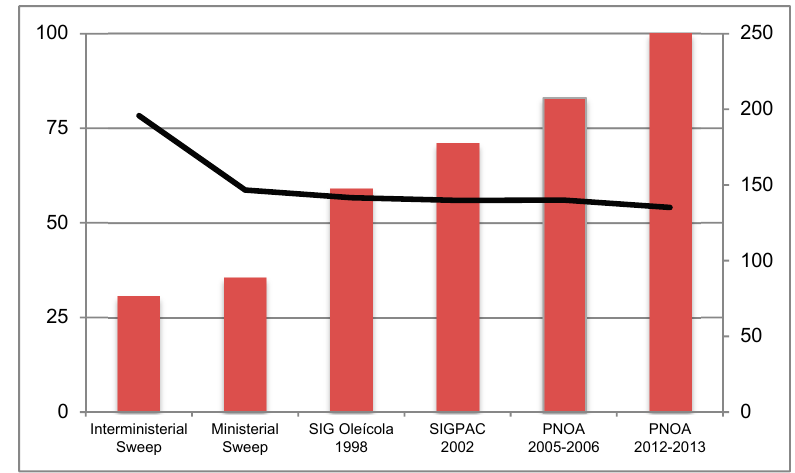
Figure 8. Evolution of rurban development in Extremadura. The percentage of the total number of homes built on UL (bars) and average area (m 2 ) of homes (lines).